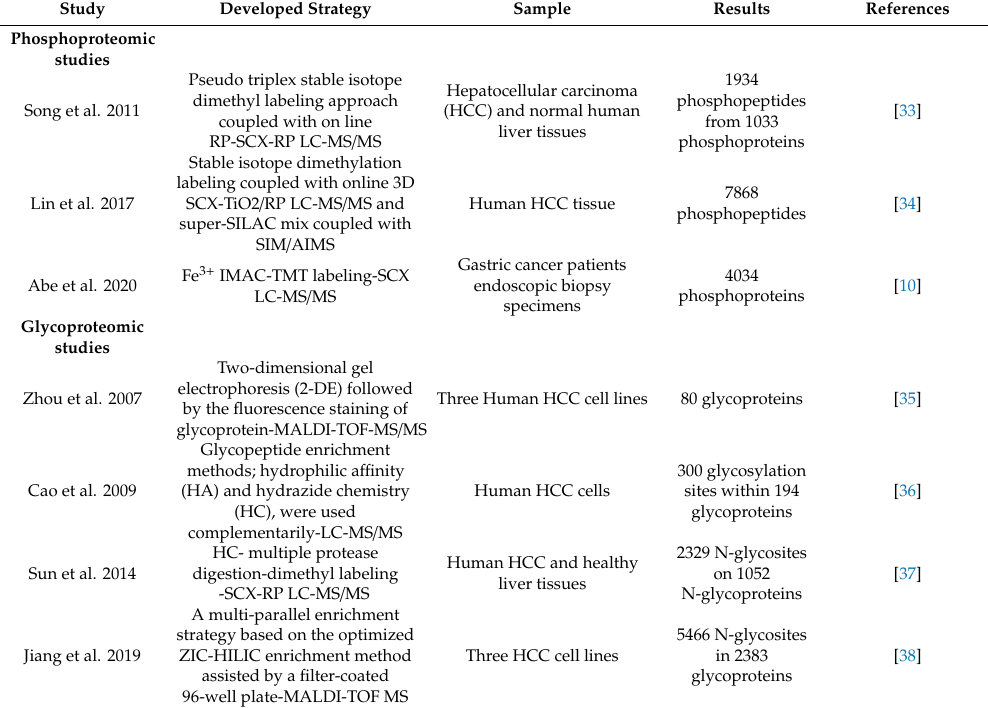
Table 1. Summary of developed methods for phosphoproteome and glycoproteome analyses in GI